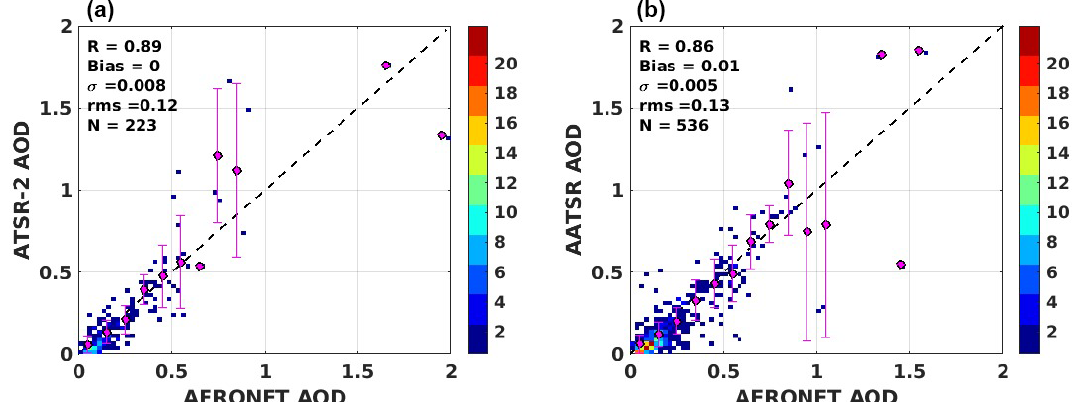
Figure 5. Density scatterplot of ATSR-2 AOD (a) and AATSR AOD (b) vs. AOD from AERONET stations globally for the period from August to December 2002. The filled circles are the averaged ATSR AOD binned in 0.1 AERONET AOD intervals (0.25 for AERONET AOD > 1.0) and the vertical lines on each circle represent the 1 σ standard deviation. Statistics in the upper left corner indicate the correlation coefficient R , the bias, the standard deviation, the root mean square (rms) error and the number of data points ( N ). The color bar on the right indicates the number of data points in each